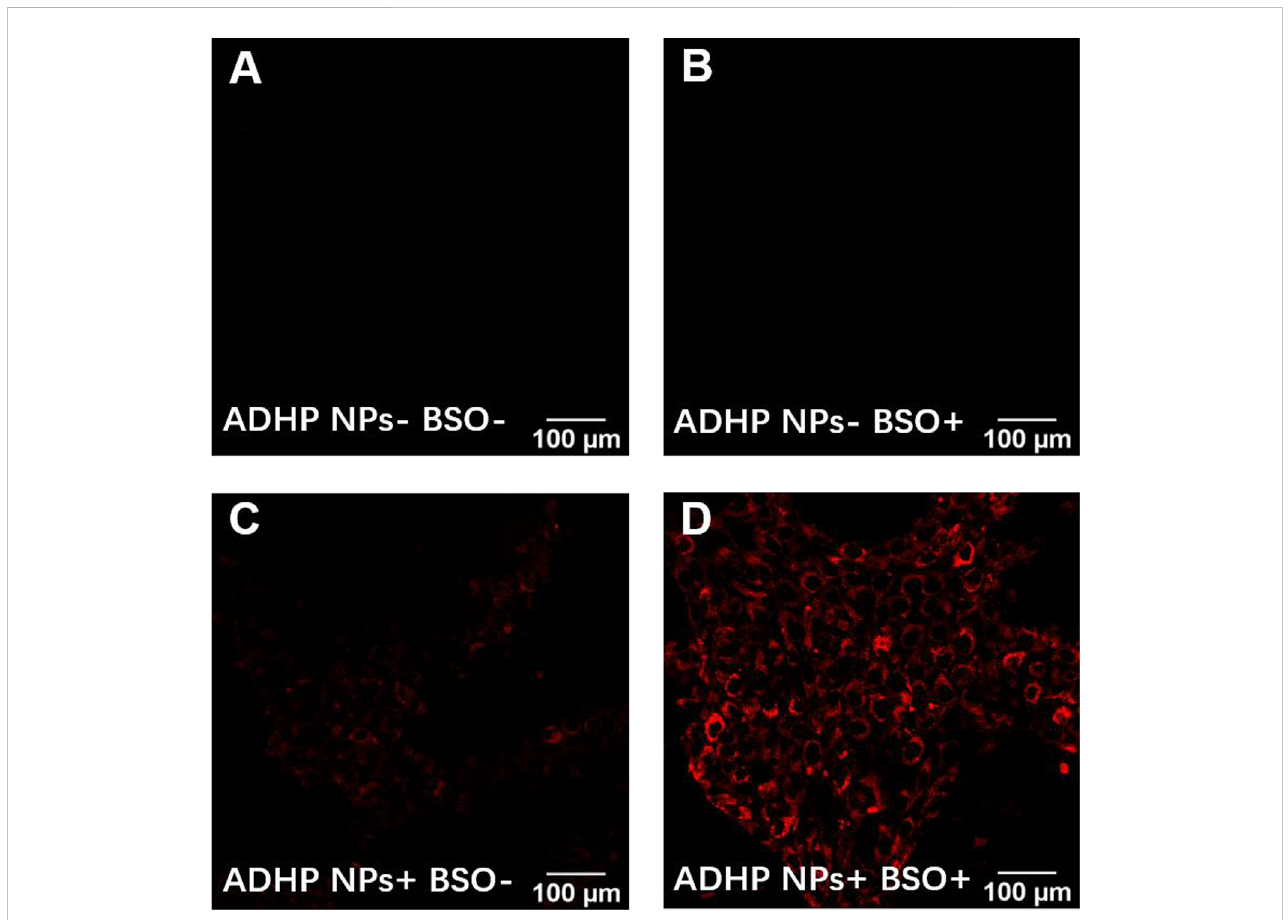
FIGURE 5 Imaging under fl uorescence microscope of ADHP NPs in vitro : 4T1 cells (A) incubated with PBS for 7 h, (B) preincubated with PBS for 4 h, later were exposed to BSO (50 mM) for another 3 h, (C) incubated with ADHP NPs(2 μ M) for 7 h, (D) preincubated with ADHP NPs (2 μ M) for 4 h, later were added BSO (50 mM) and incubated for another 3